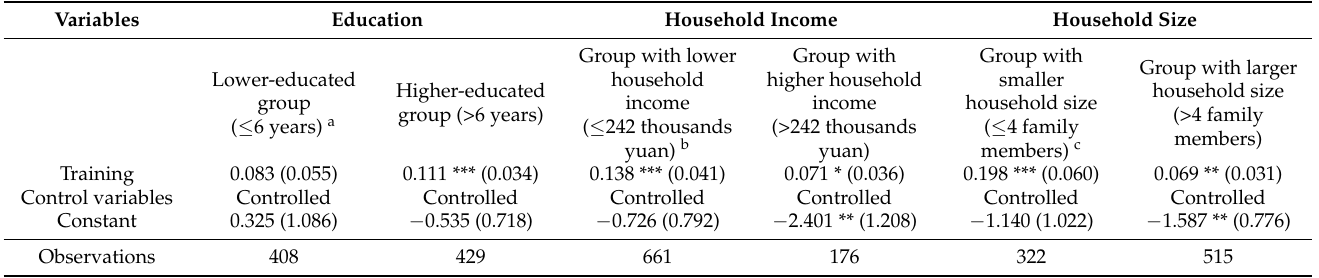
Table 5. Effects disaggregated by groups’ education, household income, and household